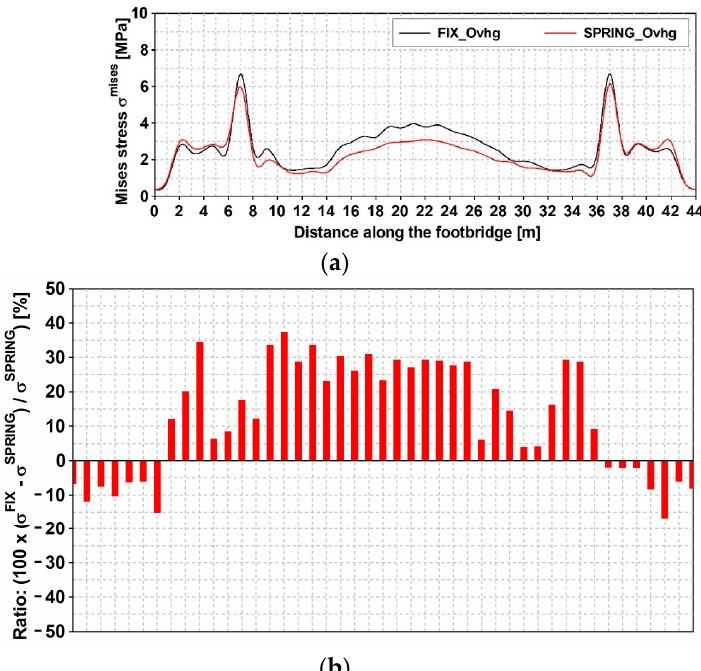
Figure 23. Mining induced stress [MPa] time histories: event with narrow band spectrum; von Mises stress along the span, at the bottom flange: ( a ) FIX_Ovhg (black line) and SPRING_Ovhg model (red line); ( b ) percentage error.